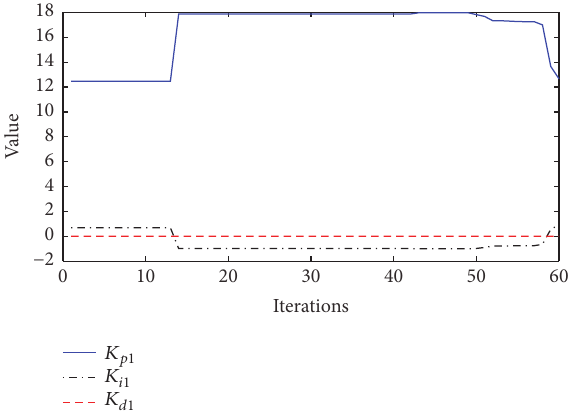
Figure 10: Improved PSO iterative process and the parameter values of PID controller 1.